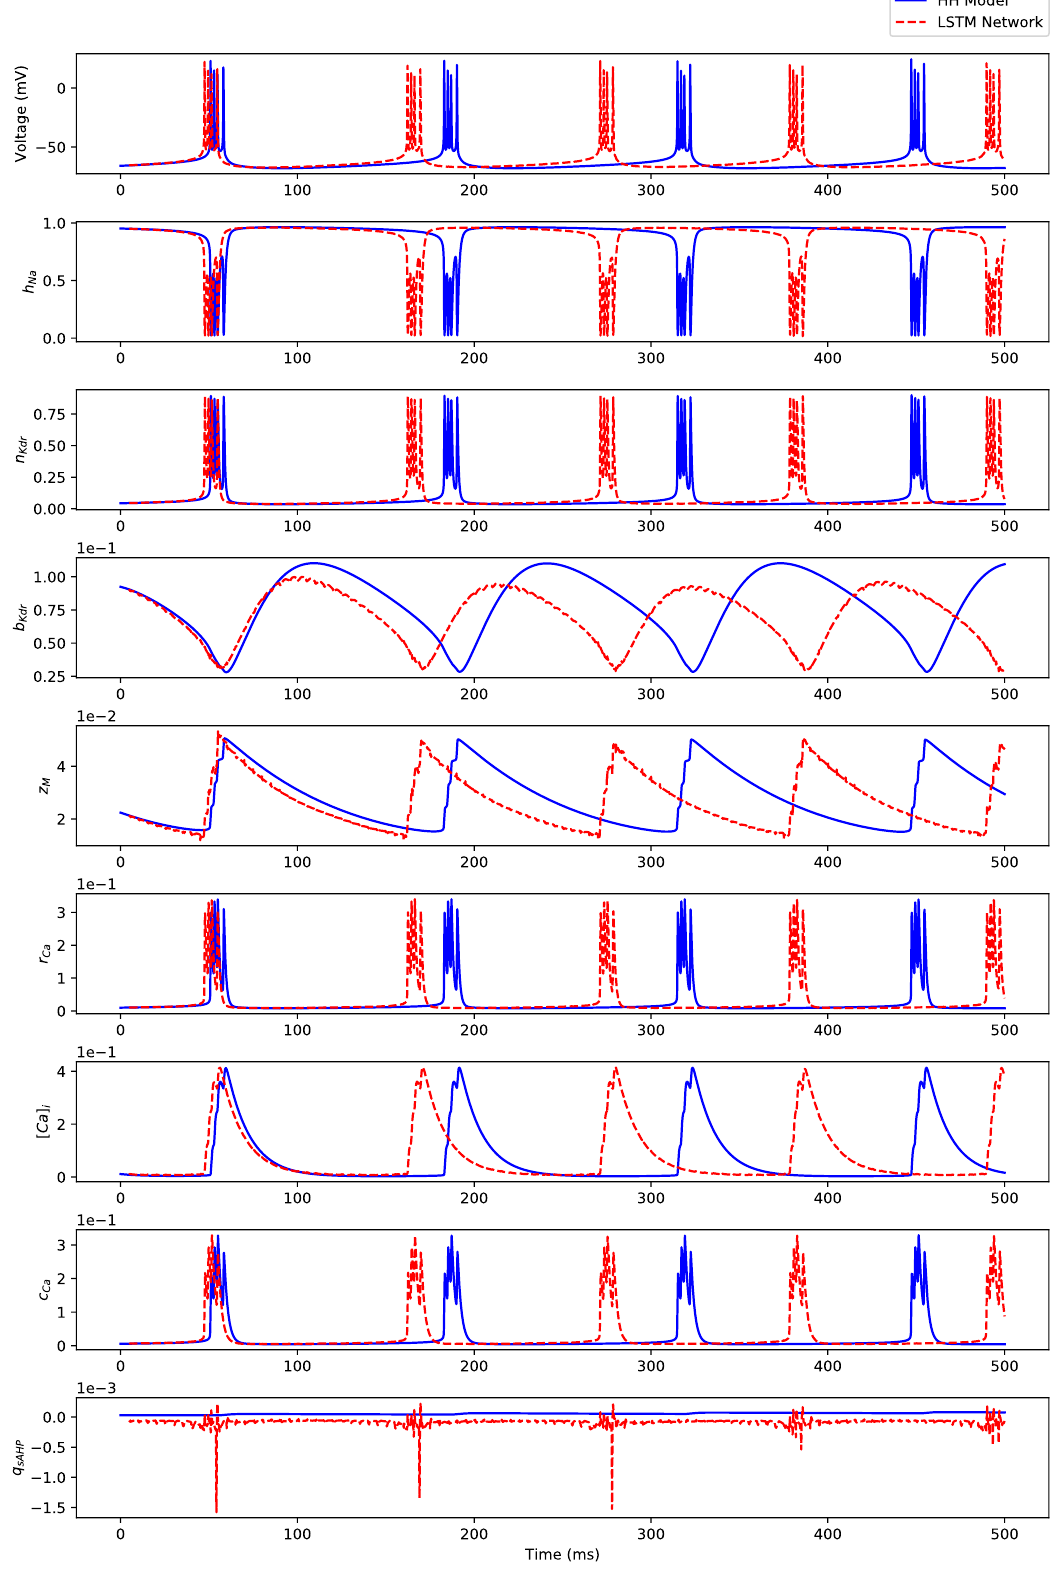
Figure A12. Comparison between the Hodgkin-Huxley model (“HH Model”) states’ dynamics and the iterative predictions of states’ dynamics using the 50 timesteps predictive horizon-based deep LSTM neural network (“LSTM Network”) in response to I = 0.5